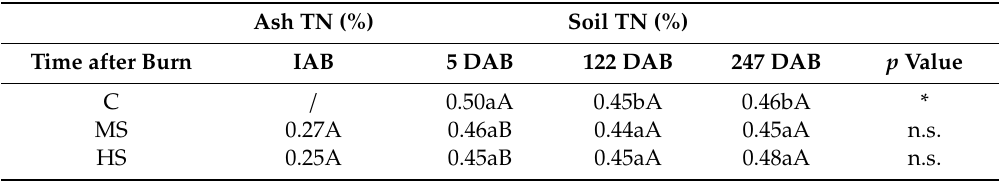
Table 1. Content of total nitrogen (TN) in ash and soil (n = 5).